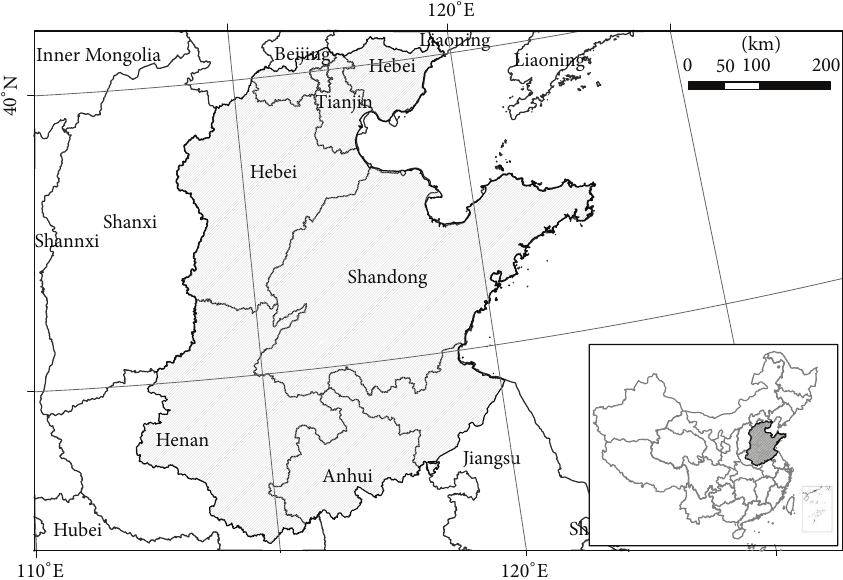
Figure 1: Location of the North China Plain.